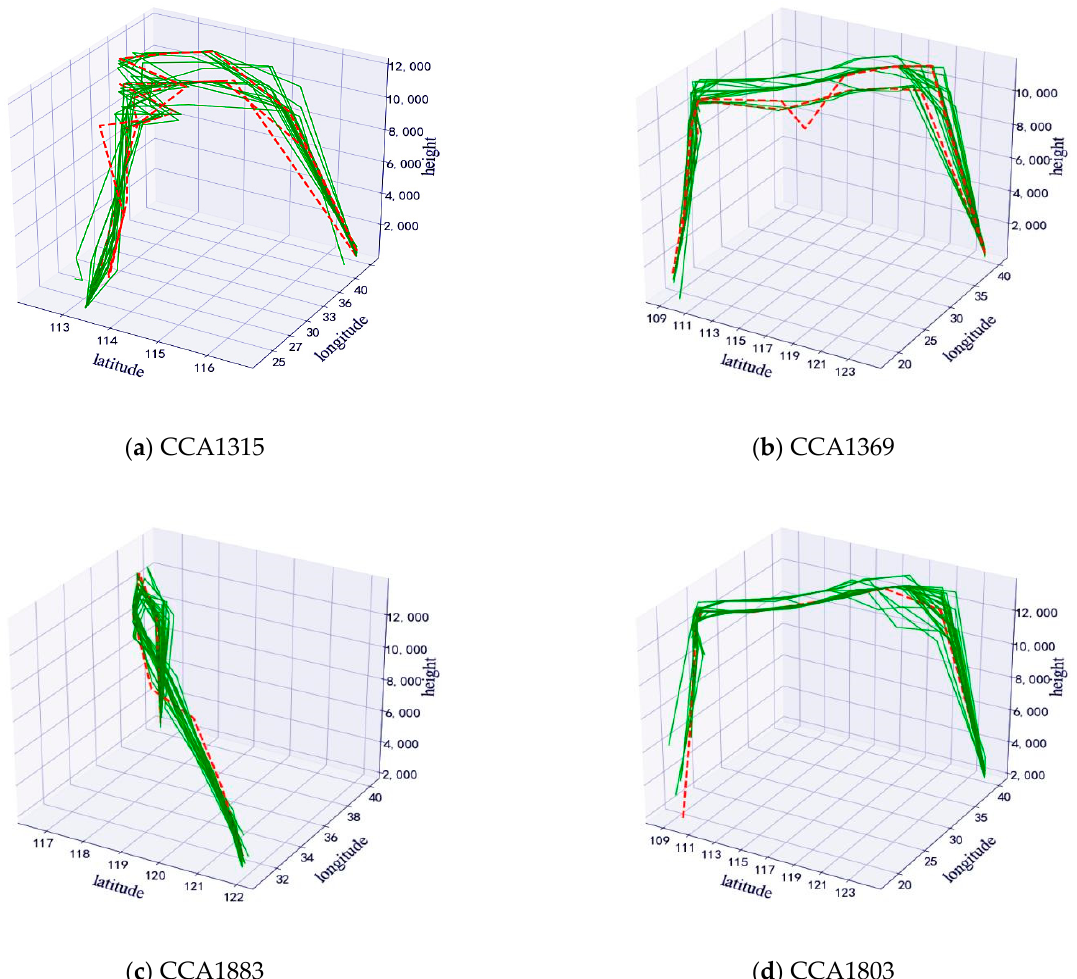
Figure 4. Track Deviation Detection Result.